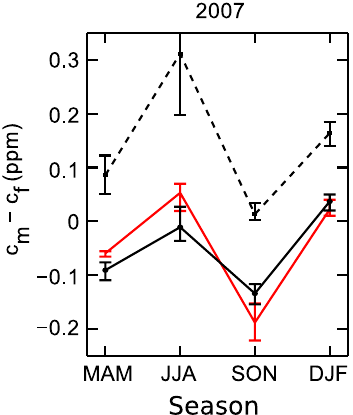
Fig. 6. Rectified vertical CO 2 gradients estimated from observations as in (c) of Fig. 5 but using NARR boundary layer depths (red lines) in addition to sonde-based boundary layer depths (solid black). CT- TM5 rectified vertical CO 2 gradients (dashed black) are shown as in Fig. 5c for